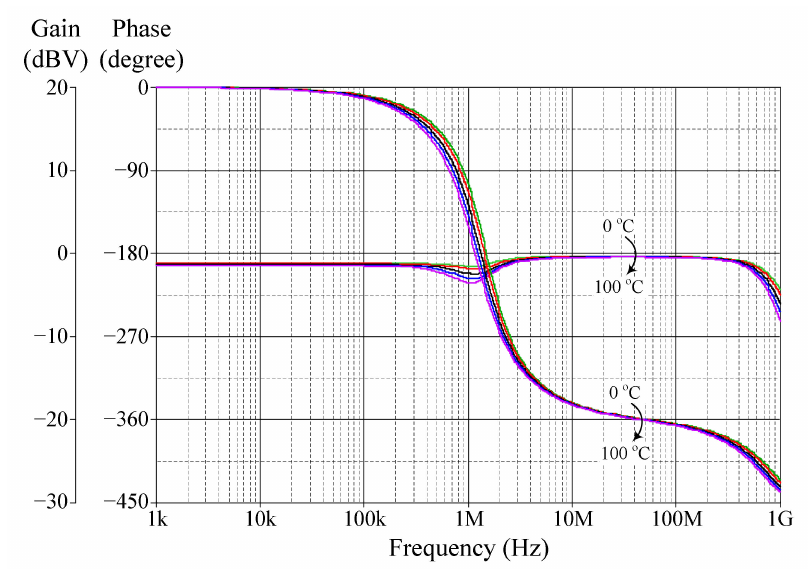
Figure 12. Simulated AP frequency responses for various temperatures (0 ◦ C, 20 ◦ C, 50 ◦ C, 75 ◦ C and 100 ◦ C).